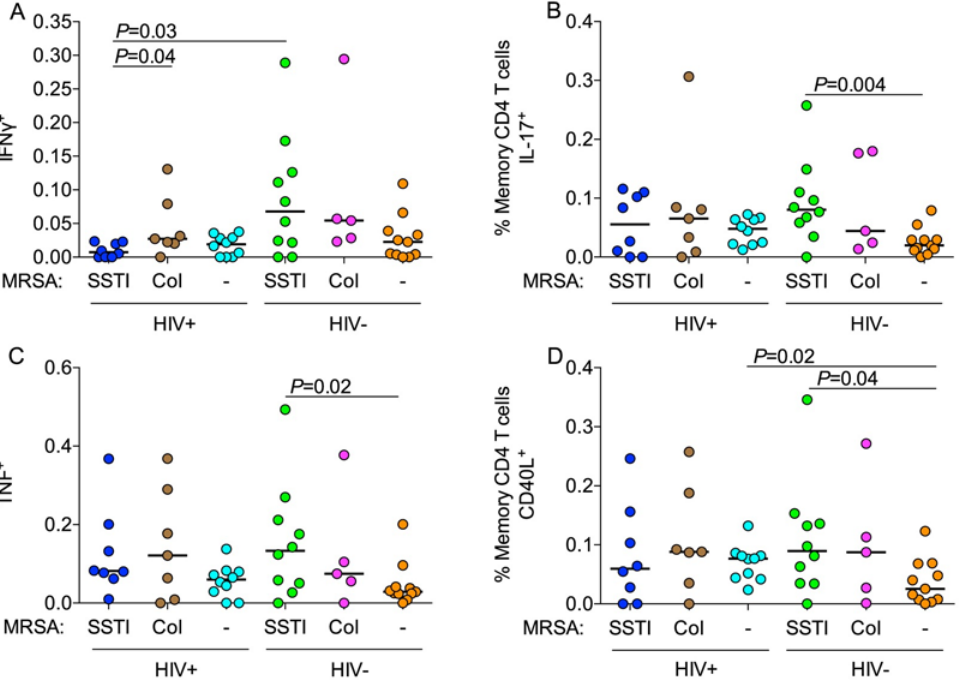
Fig 1. MRSA-specific memory CD4 T cells. Flow cytometry analysis of MRSA-specific memory (CD27 + CD45RO + or CD27 - ) CD4 T-cell responses in HIV- infected or HIV-uninfected participants with MRSA SSTI, colonization or neither. Frequency of memory CD4 T cells producing (A) IFN γ , (B) IL-17, (C) TNF and (D) CD40L. For all figures, horizontal lines indicate medians. P -values were calculated using the Mann-Whitney U